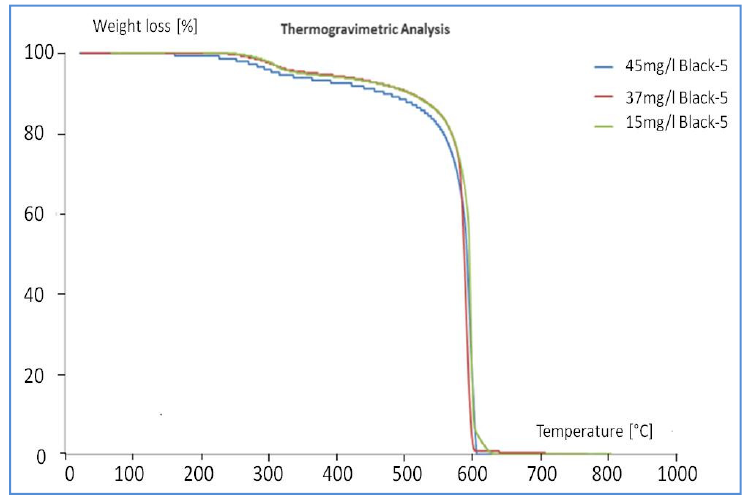
Figure 11. TG curves of purified MWCNTs after adsorption of the different solutions.